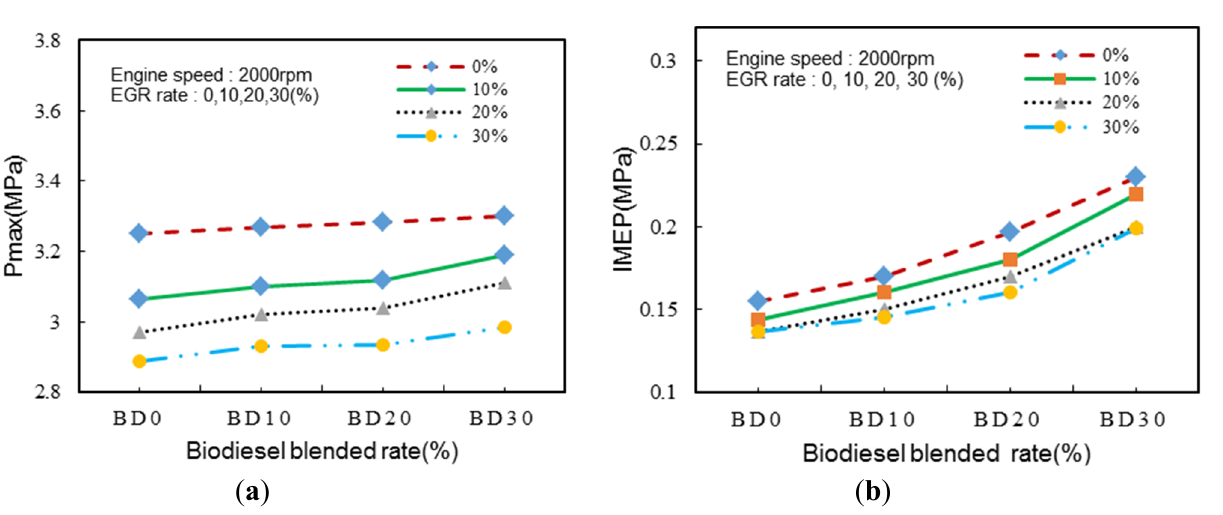
Figure 8. Effects of EGR and the biodiesel blend ratio on the ( a ) peak combustion pressure and ( b )